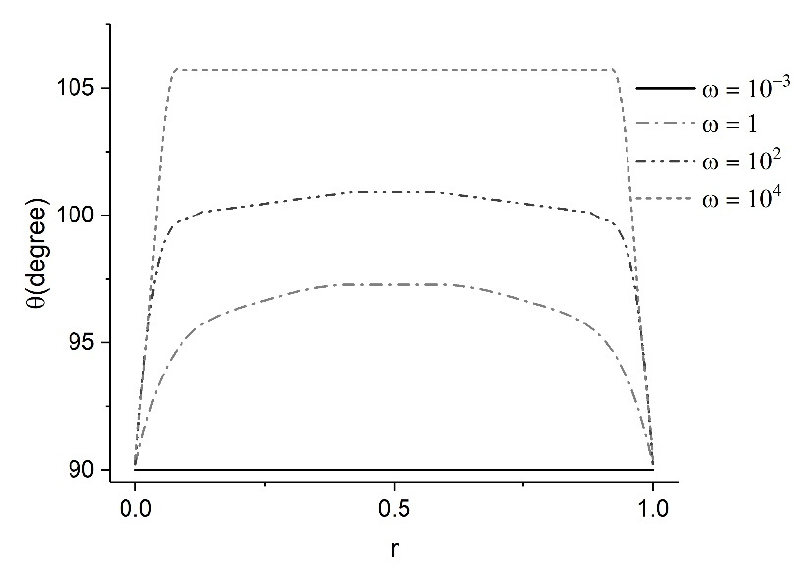
Figure 7. Stable solution branch for 20 mg/mL GO showing the increase in non-dimensionless shear rate results in orientation reaching alignment value using the EL theory.